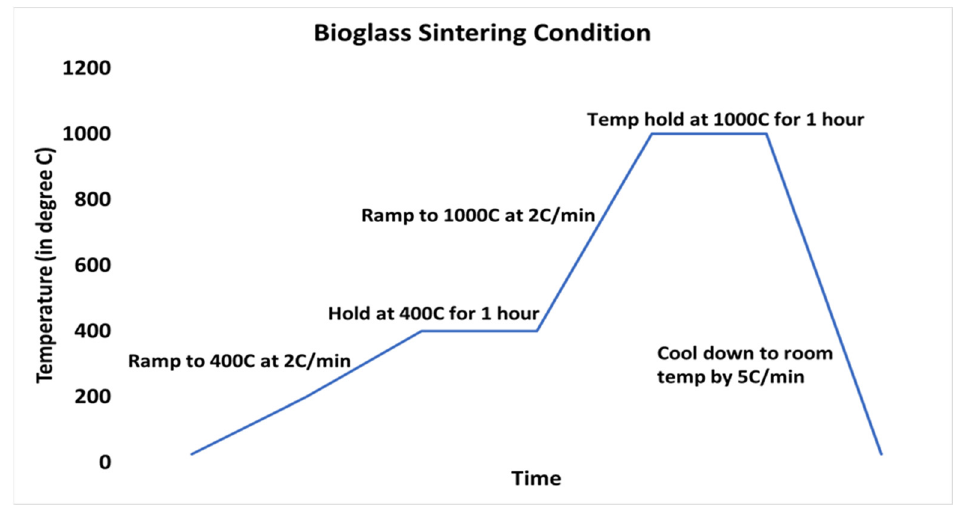
Figure 1 . Profile of the heating and sintering temperatures during BG fabrication.